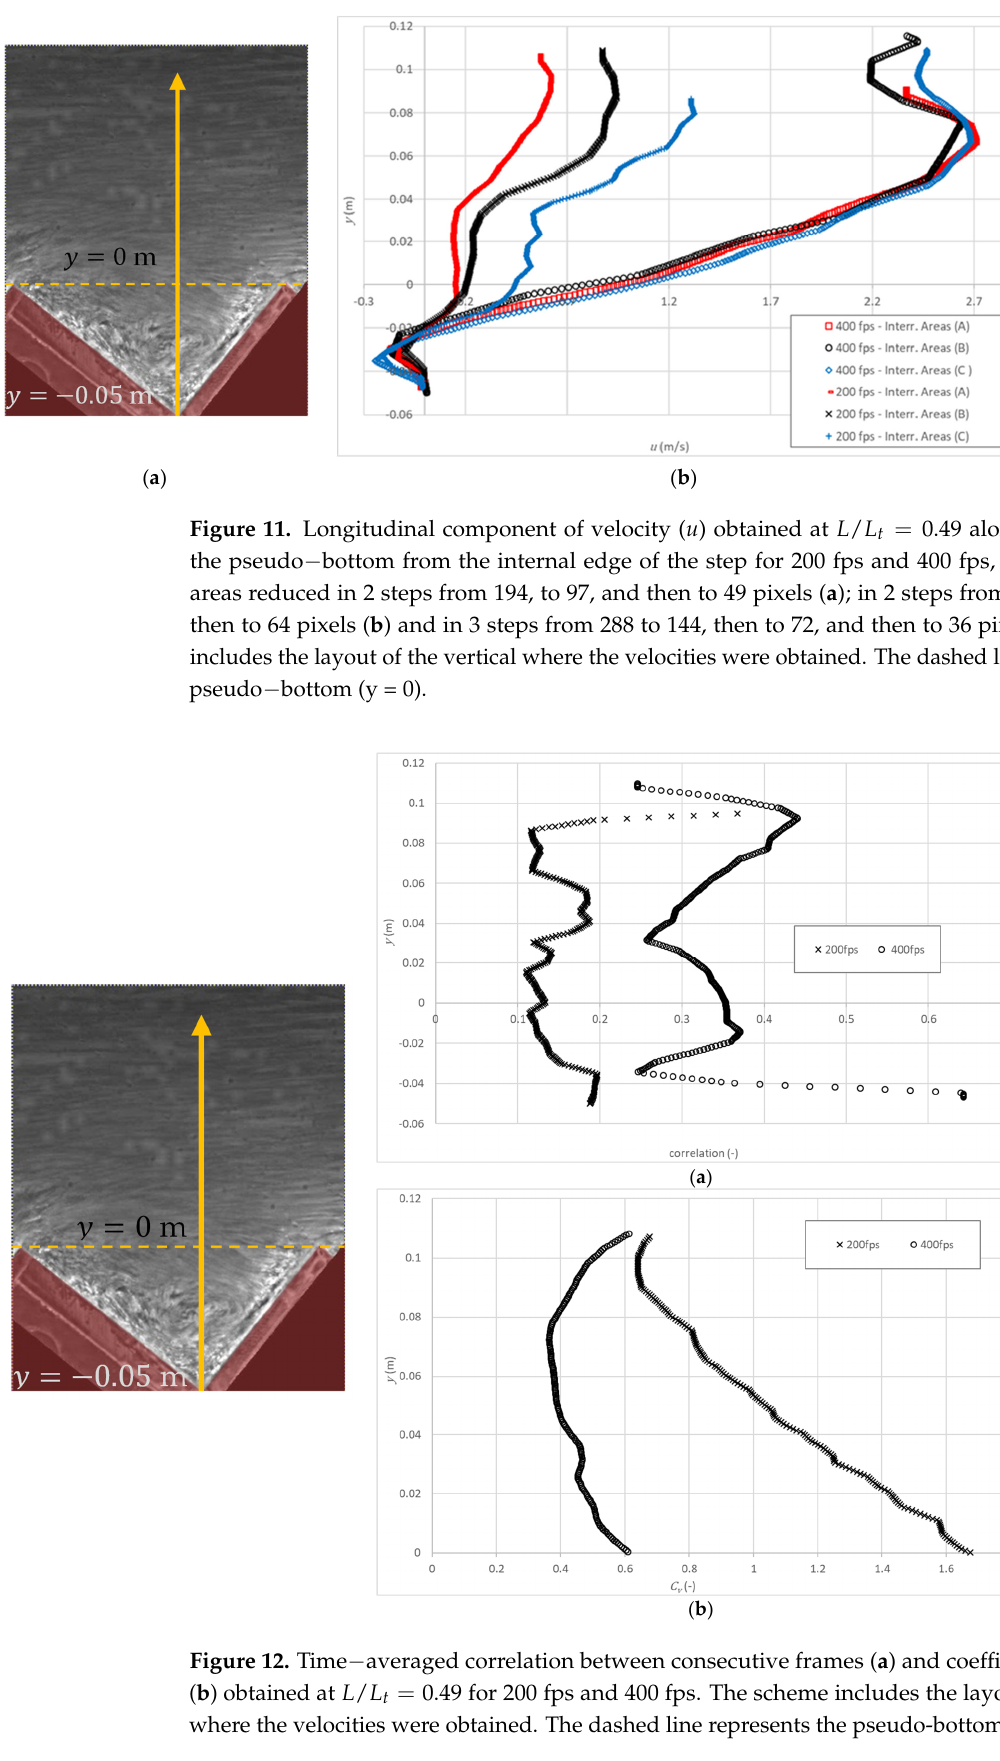
Figure 12. Time − averaged correlation between consecutive frames ( a ) and coefficient of variation ( b ) obtained at L / L t = 0.49 for 200 fps and 400 fps. The scheme includes the layout of the vertical where the velocities were obtained. The dashed line represents the pseudo-bottom (y = 0).